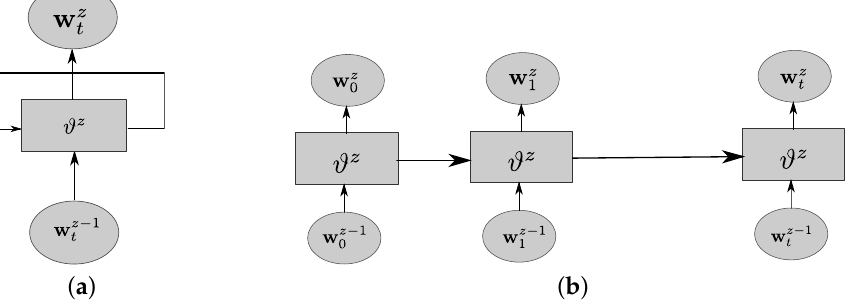
Figure 3. ( a ) A compact representation and ( b ) an unrolled representation of a recurrent neural network.